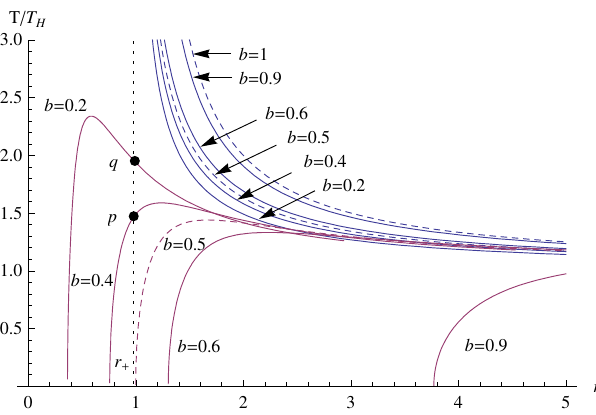
Figure 3. Freely falling temperatures T DF / T H in the unit of the Hawking temperature in a drip frame (lower curves) and fiducial temperatures T FID / T H (upper curves) along r for b = 0.2, 0.4, 0.5, 0.6, 0.9, and 1. The dotted line at r = 1 is for the horizon r + . Note that there is no freely falling temperature for b = 1, which is imaginary for all x as easily seen in Equation (116). Freely falling temperatures for b < 0.5 can be drawn beyond the horizon (over p and q in the figure) by freely falling observers who are described by the PG coordinates, while fiducial temperatures described by the original RN coordinates cannot be drawn due to divergences at the